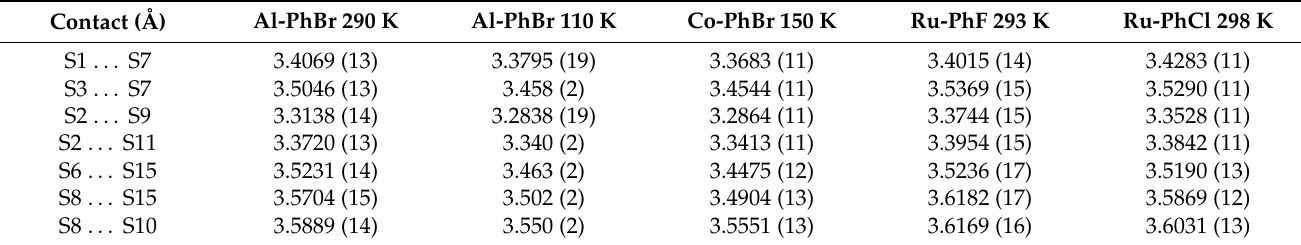
Table 2. S . . . S close contacts below the van der Waals distance in β ”-(BEDT-TTF) 4 (H 3 O) M (C 2 O 4 ) 3 · G